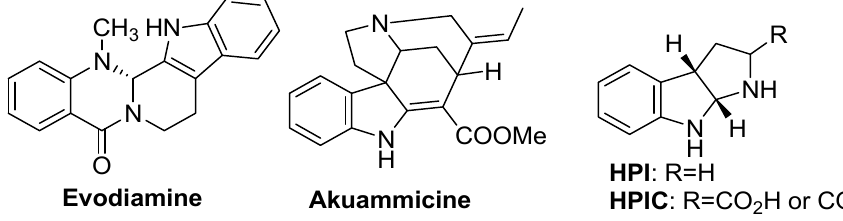
Figure 15. Evodiamine as multipurpose herbal medicine, akummicine for diabetes, HPI and HPIC.